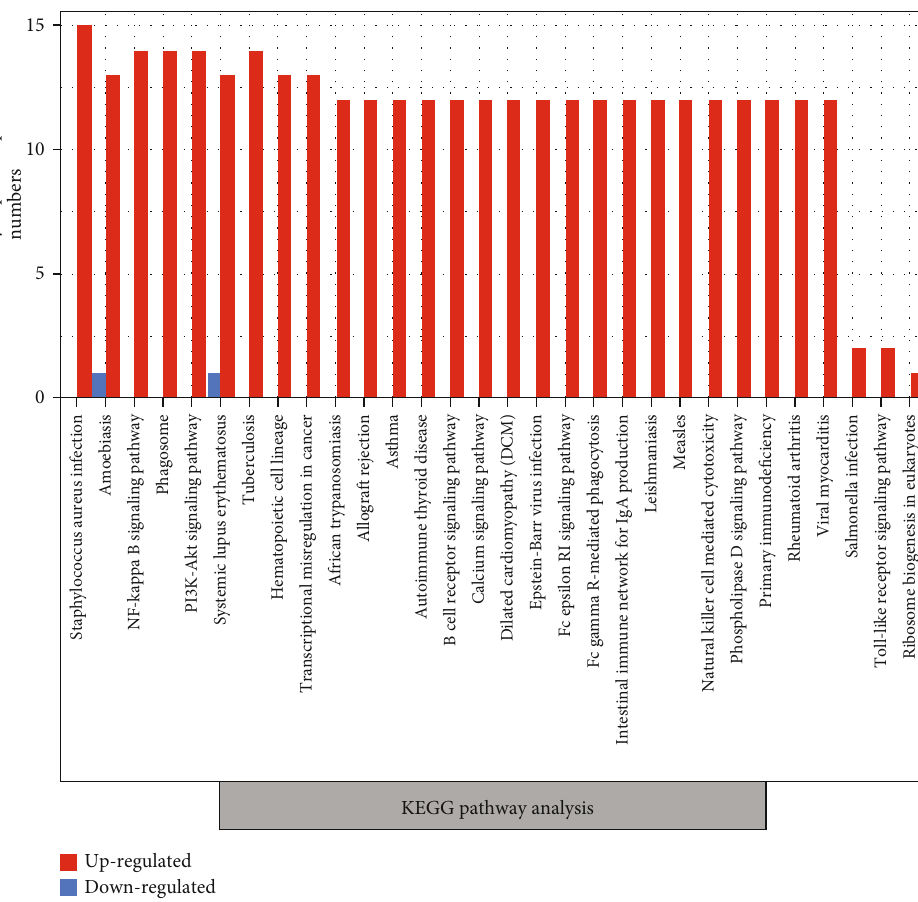
Figure 4: Pathway analysis of di ff erentially expressed proteins in rheumatoid